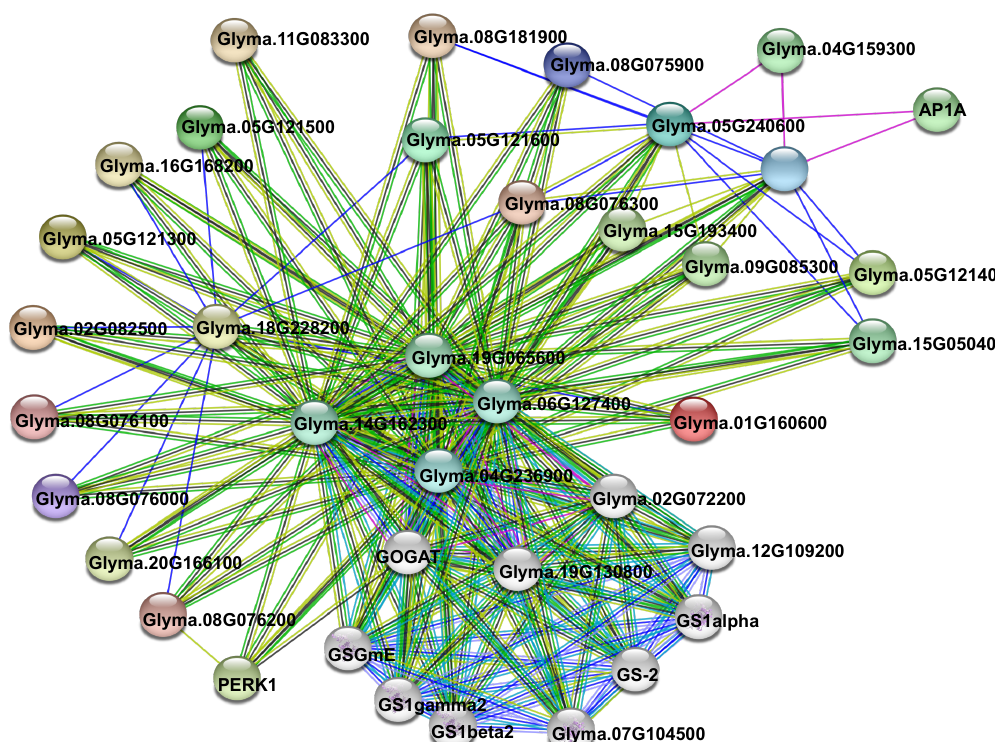
Figure 5. Functional network assembly of the soybean VIT genes. 211 interactions were exhibited among a total of 37 genes. Colored nodes mean query VIT proteins and first shell of interactors, and white nodes stand for the second shell of interactors. Light blue and purple lines represent the known interactions from cured databases and experimentally determined, respectively. Green, red, and blue lines stand for the predicted interactions from gene neighborhood, fusions, and co-occurrence, respectively. In addition, Light green, black, and dark blue lines represent other interactions from textmining, co-expression, and protein homology,